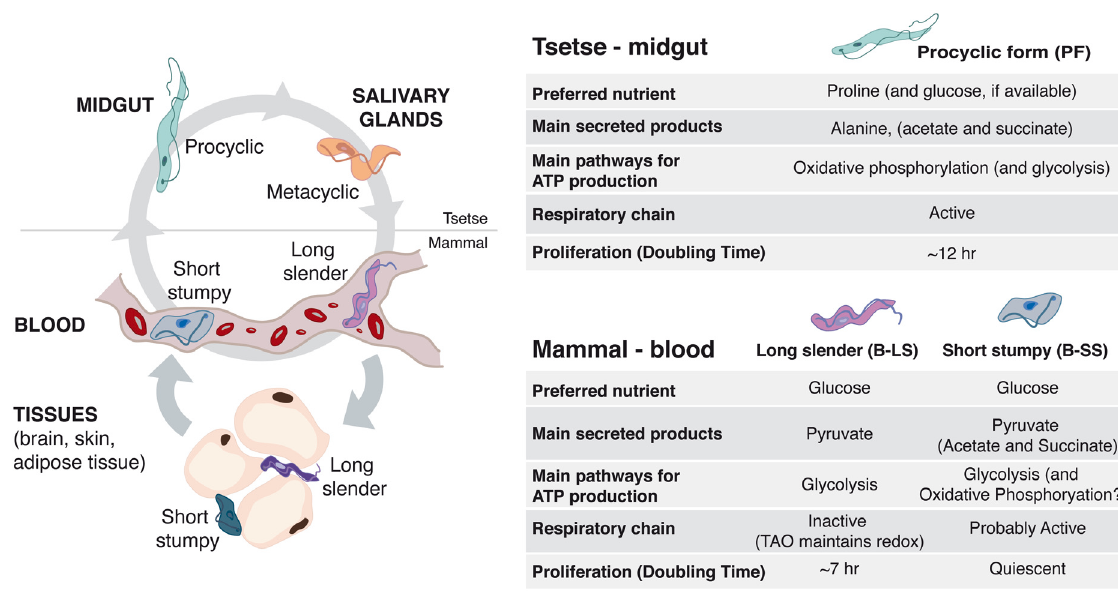
Figure 1. Changes in metabolism during the life cycle of Trypanosoma brucei . T. brucei life cycle spans two hosts: a mammal (human, cattle, wild animals) and the tsetse fly. As this protozoan parasite is extracellular, it adapts its metabolism to the available extracellular nutrients. The two stages that have been better characterised in terms of metabolism are the bloodstream long slender and procyclic forms, which mainly catabolise glucose and proline, respectively. Fewer studies have studied bloodstream short stumpy forms. In the mammalian host, parasites accumulate in the interstitial spaces of several tissues, mainly the brain, skin and visceral adipose tissue (adipocytes are shown as an example). The metabolism of parasites in these tissues remains mostly unknown, except for the activation of fatty acid β -oxidation in parasites resident of the adipose tissue. Metabolism of metacyclic stage has not been characterised to date. TAO, trypanosome alternative